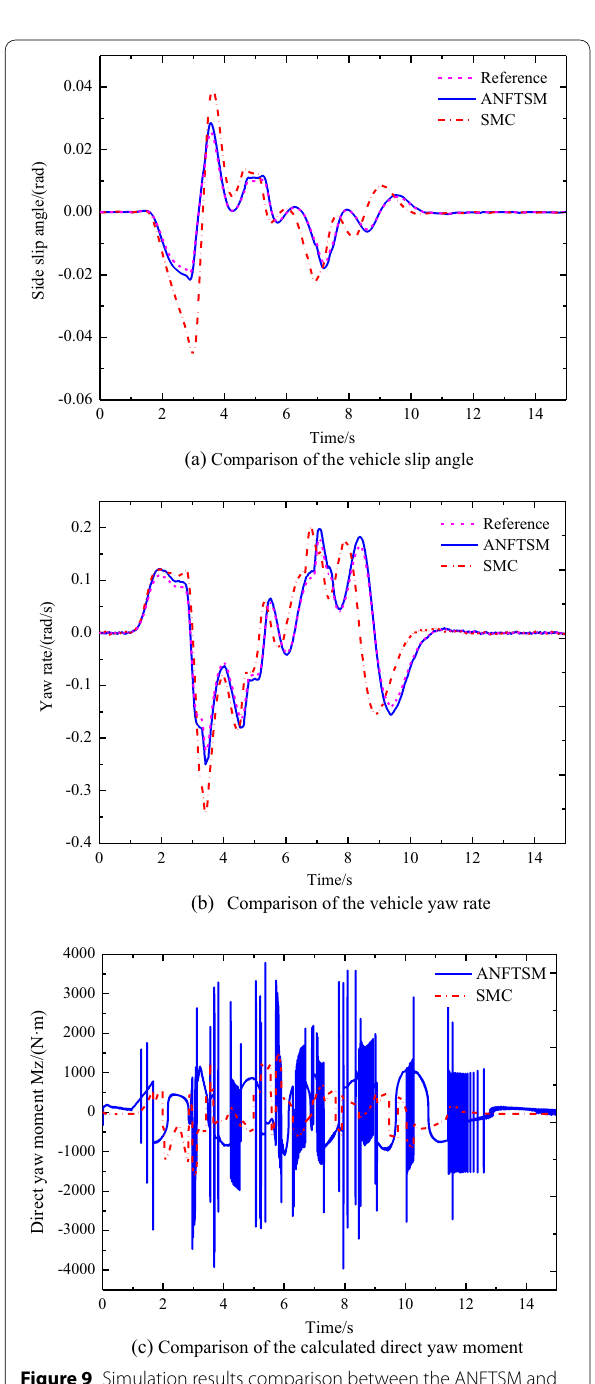
Figure 9 Simulation results comparison between the ANFTSM and the SMC ( μ =